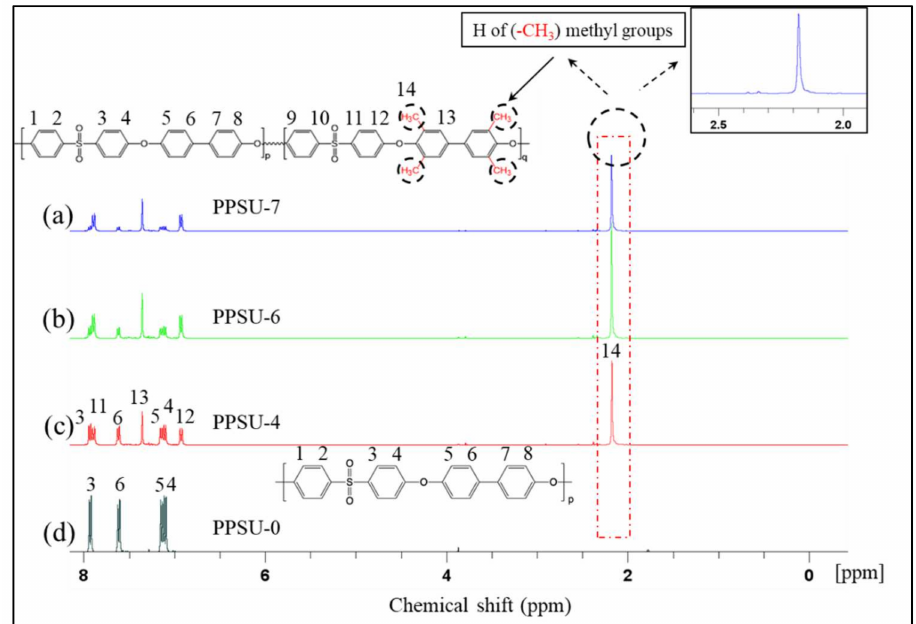
Figure 3. Spectra of 1H NMR of ( a ) PPSU-7, ( b ) PPSU-6, ( c ) PPSU-4, and ( d ) PPSU-0. The signal at around 2.20 ppm in spectra a, b, c reveals 1 type of proton (H) in methyl groups on the benzene rings of PPSU-4, PPSU-6, and